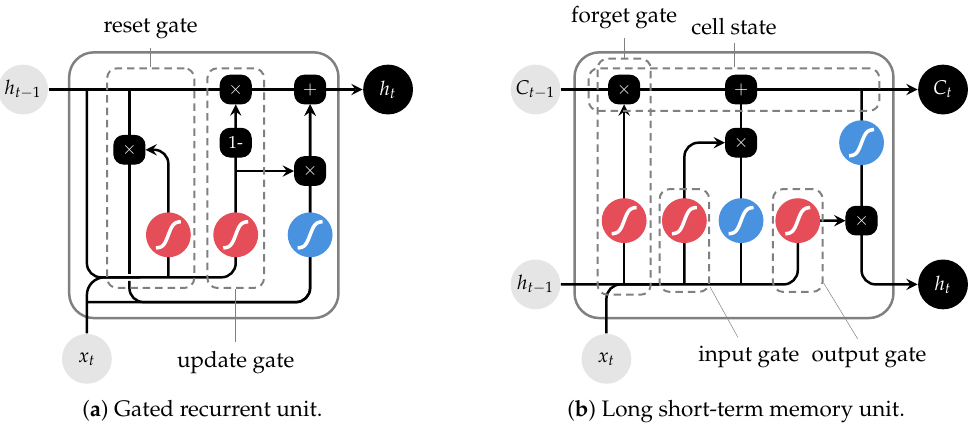
Figure 5. Basic architectures of the most common topologies of RNNs: ( a ) the GRU and ( b ) the LSTM unit. The arrow lines indicate the flow of information through each unit; vector concate- nation takes place in zones where two lines adjoin. The sum and multiplication operators refer to pointwise operations. Red and blue blocks represent sigmoid and hyperbolic tangent signal activations,